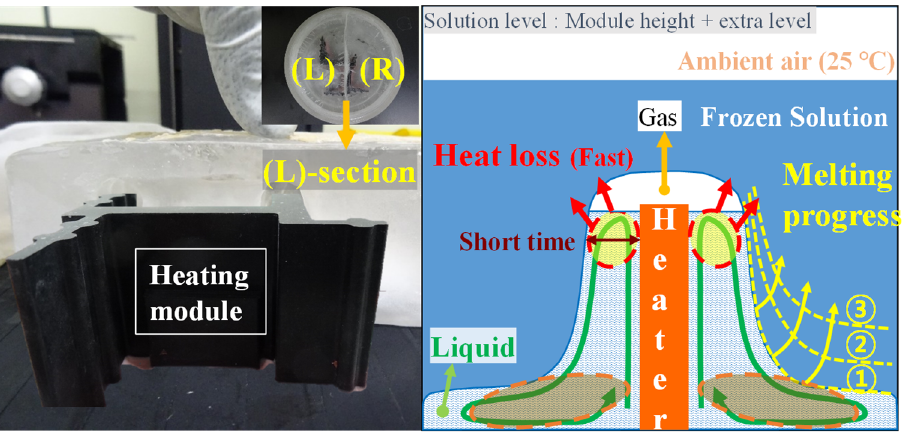
Figure 8. Section view of frozen solution and schematic of phenomenon according to time (Mod- ule_1); condition : Case_2 (level: Module height + extra level)/420 s.